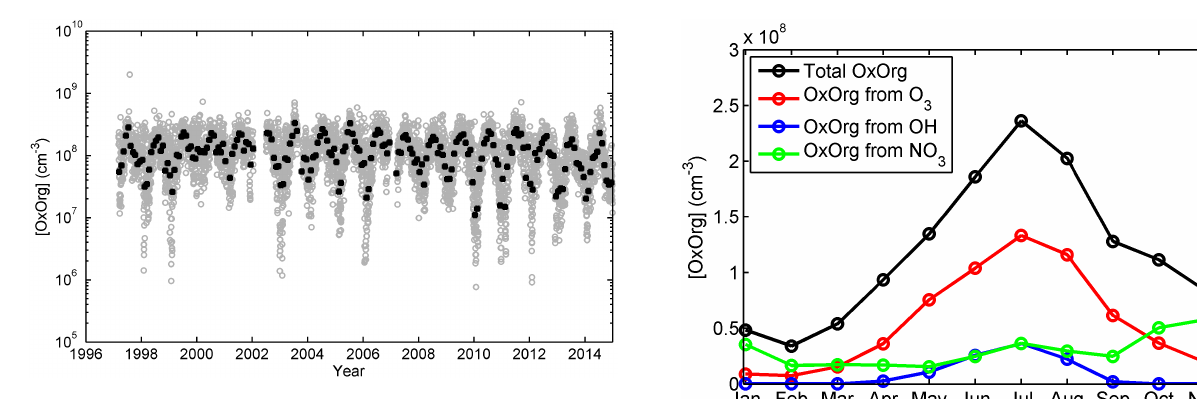
Figure 8. The proxy for oxidation products of monoterpenes (Ox- Org) during the years 1996–2014. The gray circles show the median concentration for each day and the black squares for each month.